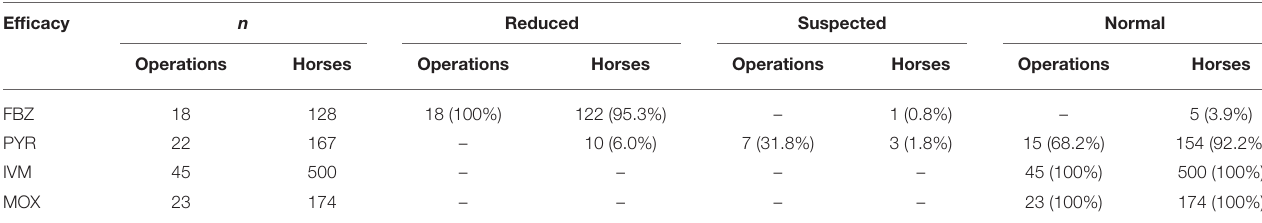
TABLE 1 | Estimated efficacies of fenbendazole (FBZ), pyrantel embonate (PYR), ivermectin (IVM) and moxidectin (MOX) at the operation and horse levels.